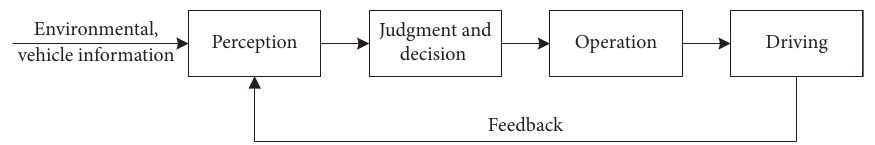
Figure 1: Control flow for vehicle maneuver